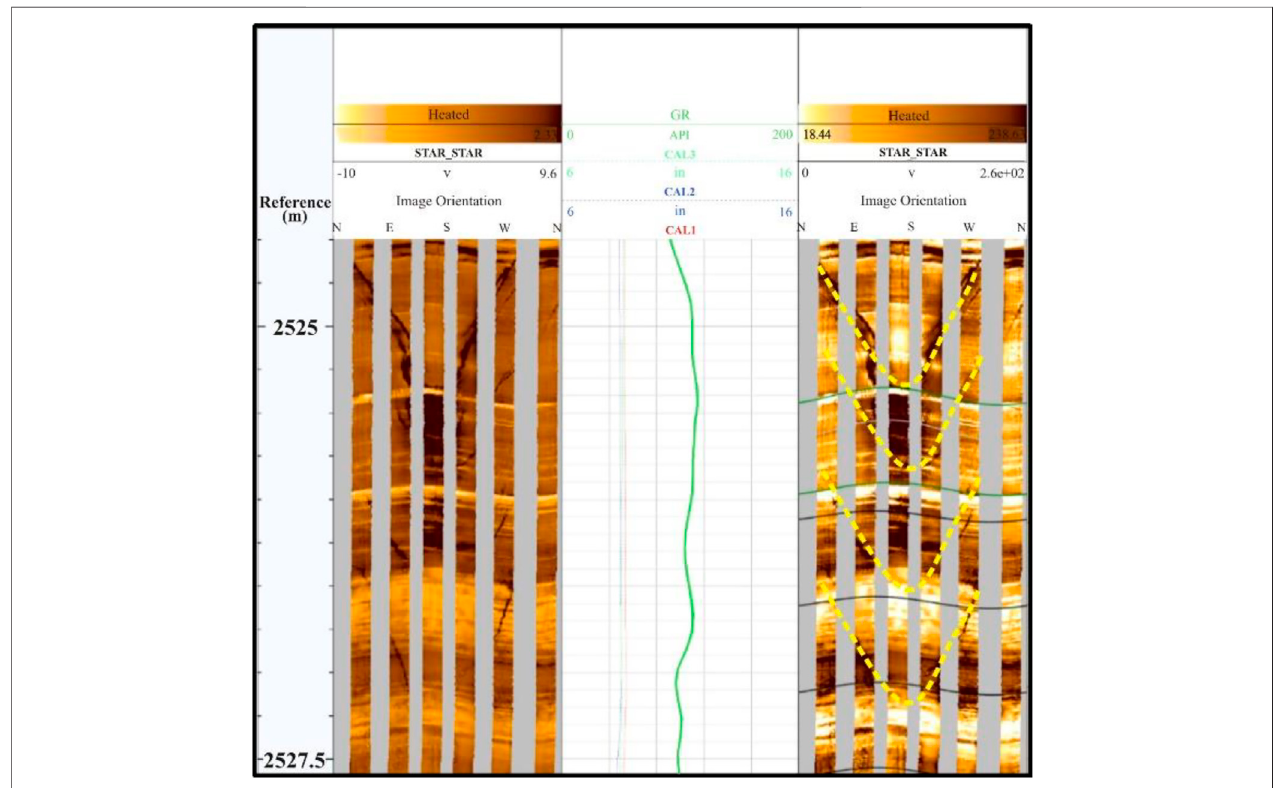
FIGURE 7 | Imaging log response of fractures in Yanchang Formation in Well D41. GR - natural gamma; CAL1~CAL3 - three well diameters measured by the six- wall dip tool.